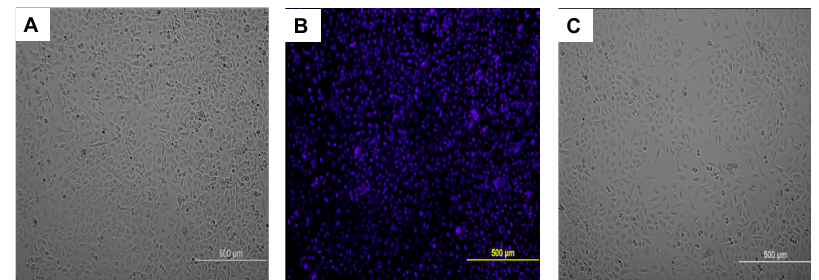
Figure 3. Cell viability following SAW measurement. Immediately following SAW measurement the viability of ( A ) A549 and ( B ) RAW 264.7 cells was determined by trypan blue exclusion. Data is plotted as mean ± standard error of the mean. The data is a representative of a study that was performed in triplicates and performed at least two independent times. A student’s t -test was used to evaluate significance (* p ≤ 0.05, when compared to control).